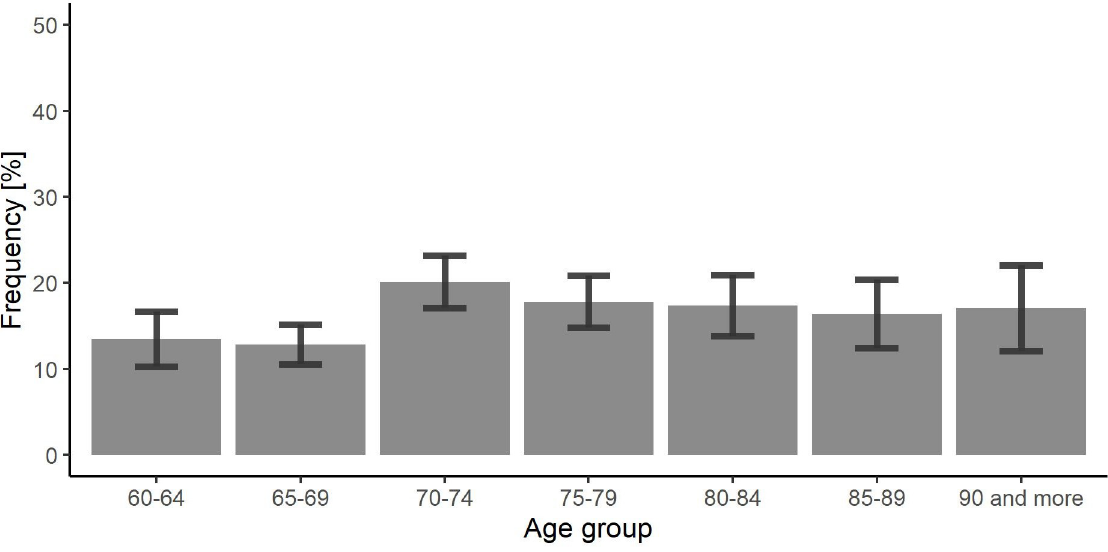
Fig 3. The frequency of thyroid dysfunction across age